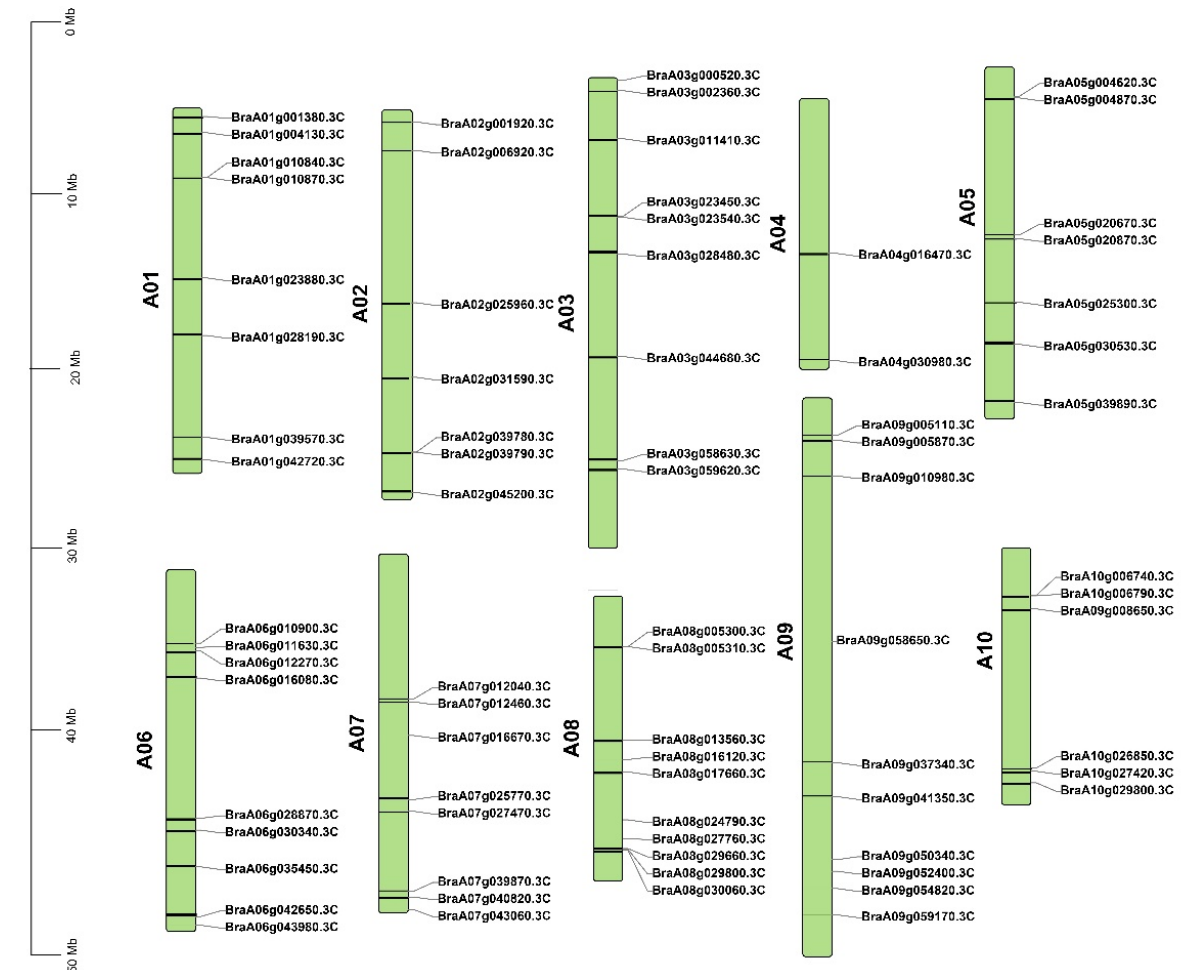
Figure 1. Chromosomal map of Brassica rapa with the distribution of the Brcyclin gene family member on the cabbage chromosome; the left scale indicates the size of each chromosome.